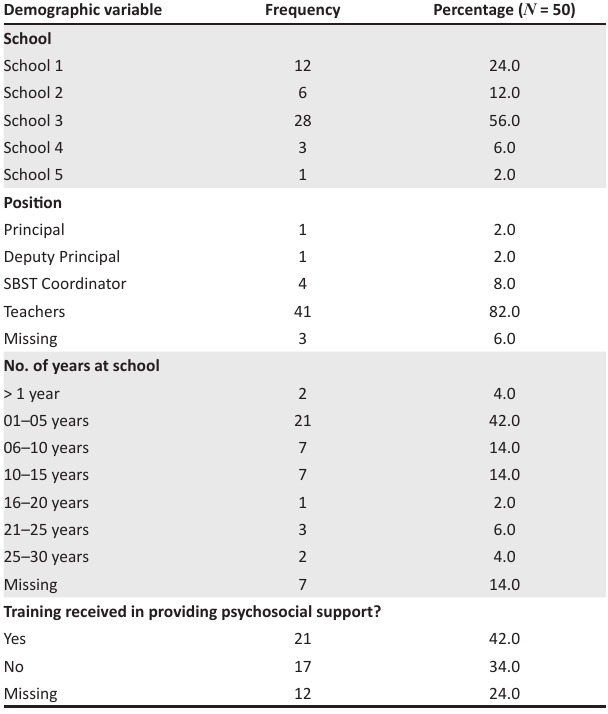
TABLE 2: Demographic data summary of the respondents.